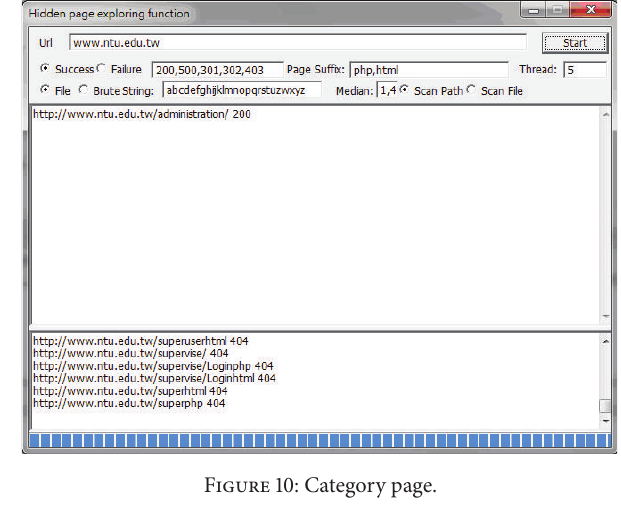
Figure 10: Category page.